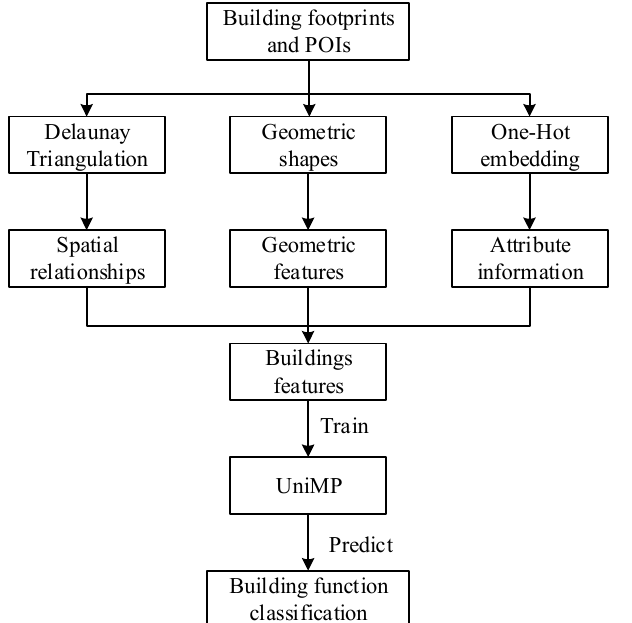
Figure 1. The workflows of building function recognition using semi-supervised classification.